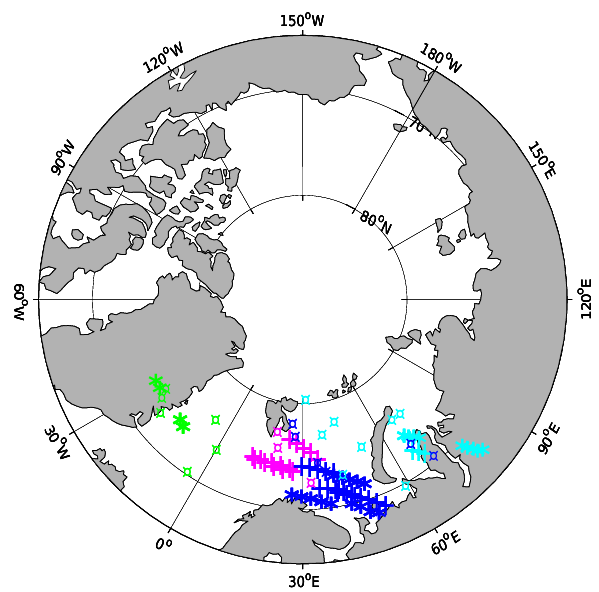
Fig. 9. The locations where T ice along the back trajectories was en- countered. The back trajectories that were started from IRF Kiruna are denoted with a star, the ones started from Esrange with a plus symbol and the CALIPSO measurements are denoted with circles. The dates when T ice was encountered are colour coded: 2 January (green), 15 January (magenta), 17 January (dark blue) and 18 Jan- uary (light blue).